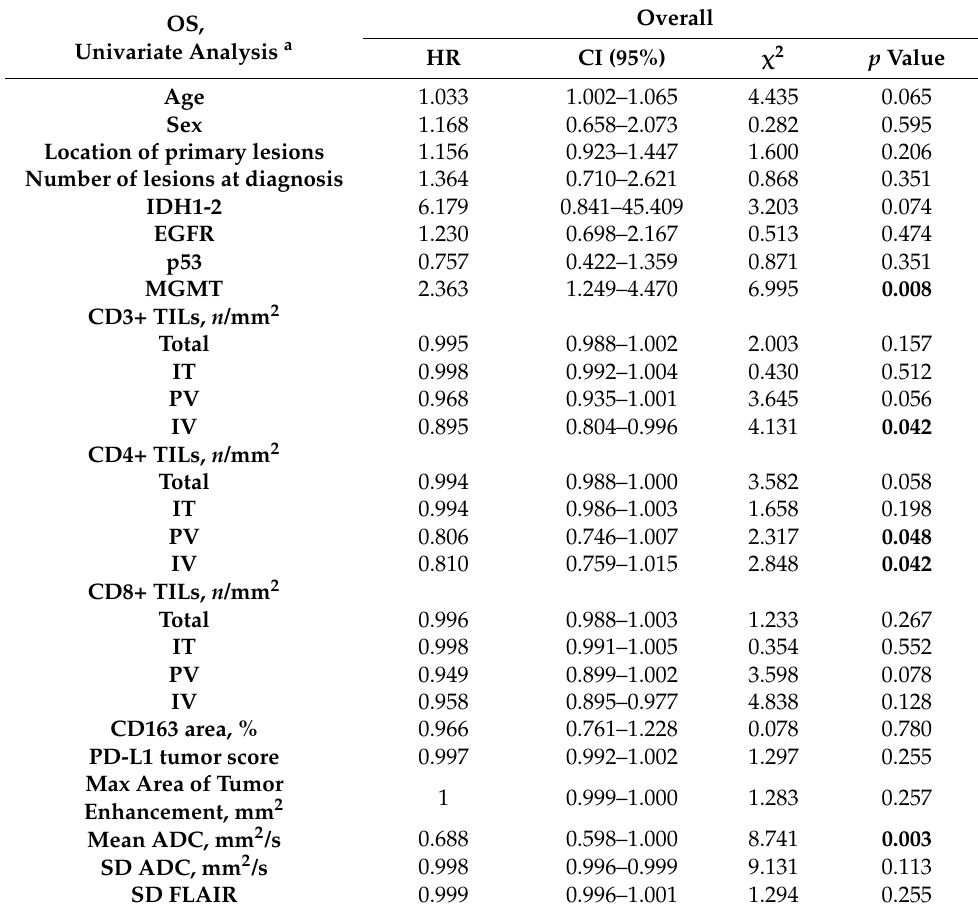
Table 4. Explanatory prognostic factors in Cox proportional hazard